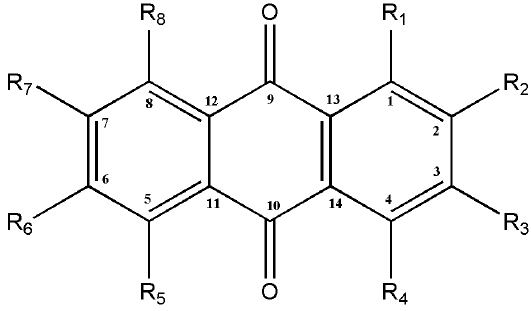
Figure 2. The general structure of anthraquinones.